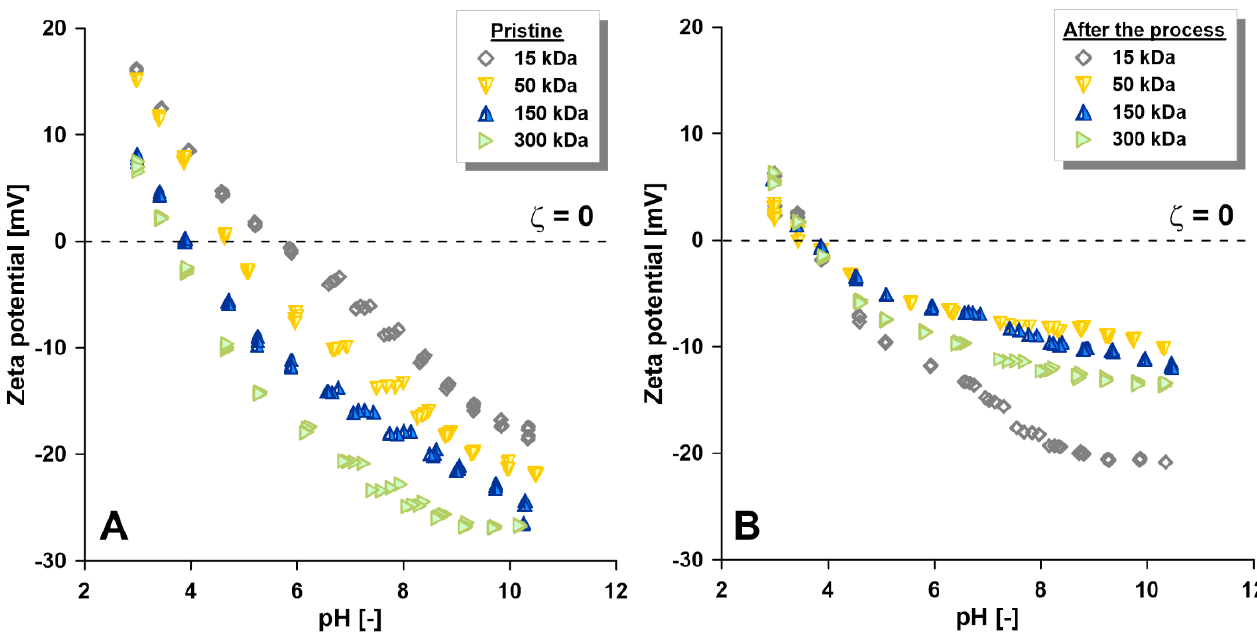
Figure 7. Zeta potential in the pH range of 3 – 10. Impact of all modification steps for the membranes with the smallest, 15 kDa ( A ), and the biggest, 300 kDa ( B ), pore size (MWCO).